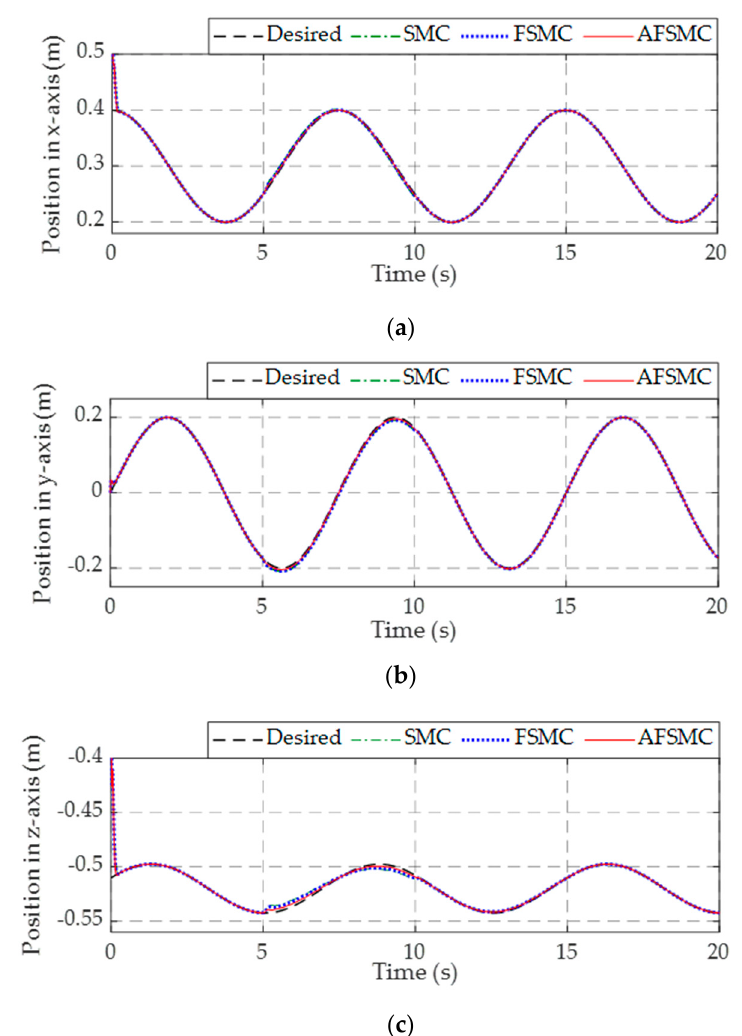
Figure 17. The tracking performance in: ( a ) x direction, ( b ) y direction, and ( c ) z direction.